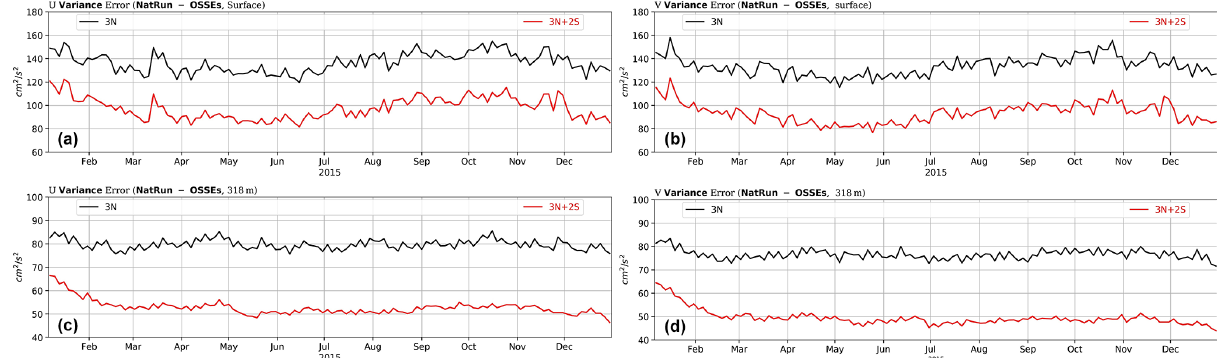
Figure 15. Temporal evolution of zonal and meridional velocity error variance (cm 2 s − 2 ) for 7d ocean analysis over the period from 1 January to 20 December 2015. The results were obtained by comparing both components of the velocity ( U,V ) to that of the NR. Black curves with assimilation of nadir altimeters (3N) and red curves with assimilation of nadirs and wide-swath instruments (3N + 2S). (a) and (b) Surface velocities and (c) and (d) velocities at 300m depth. The statistics are summarized in Table